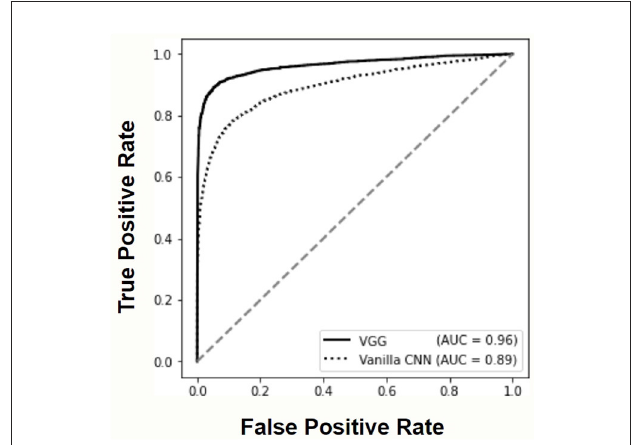
the same image array across the 3 dimensions. Image pixels were normalized by dividing each gray-scale intensity value by 255.